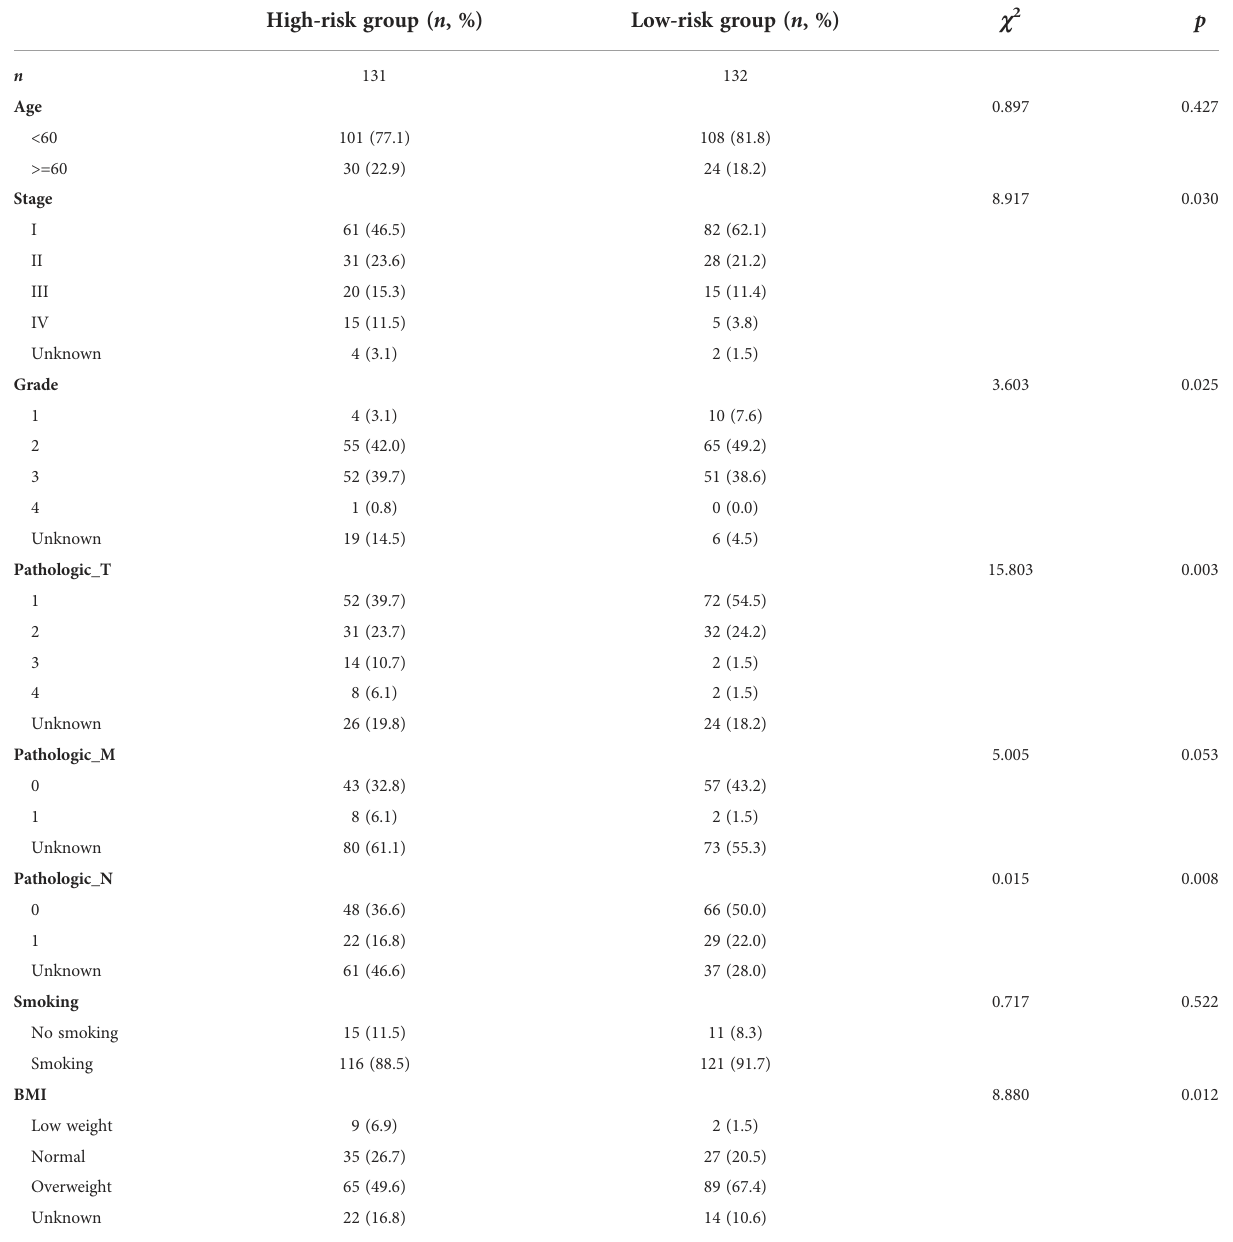
TABLE 3 Clinical characteristics of TCGA-CESC data between the two